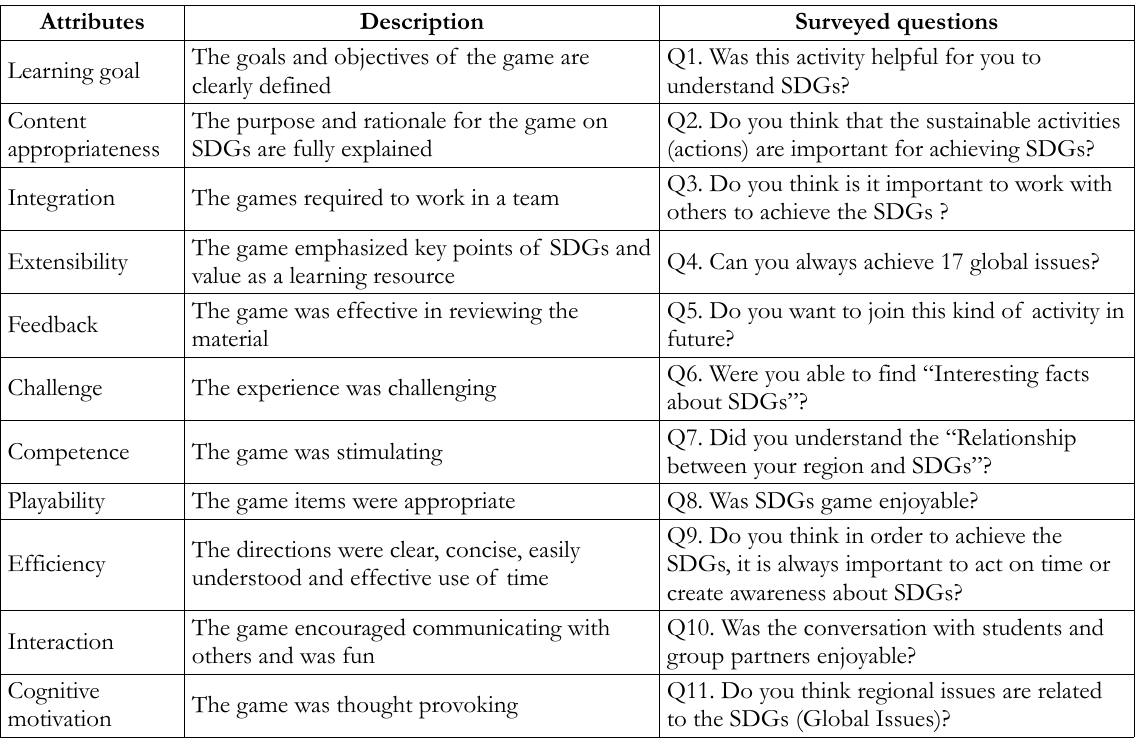
Table 1. Surveyed questions with description and considered